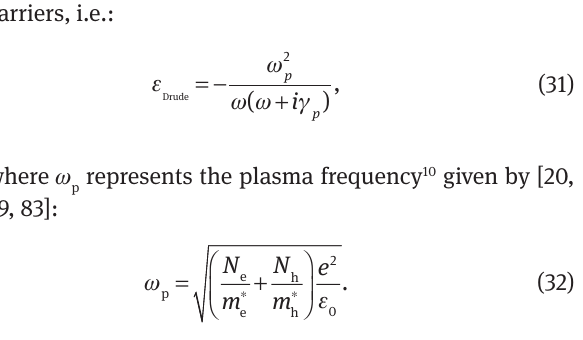
Figure 6: PhP permittivity and skin depth of widely-used semiconductors. (A) Ionic response of the permittivity (real part) without the bound-electron contribution, i.e. Re( ε λ , for different semiconductor material (for AlN and GaN which are anisotropic the response for electric field ⊥ to the c -axis is shown). 0 (B) Corresponding skin depth, δ , scaled with the free-space wavelength, λ Re( ε ) < 0). The bold orange line represents the respective value for Au, multiplied by a factor of 100 to aid the comparison. ion